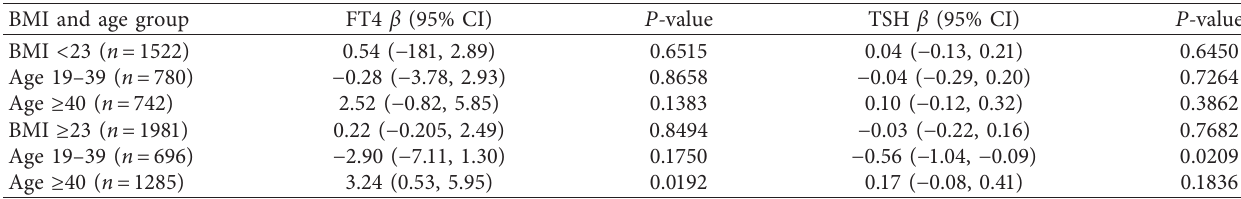
Table 3: Relation between upper limb muscle strength with thyroid hormone status according to BMI and age.